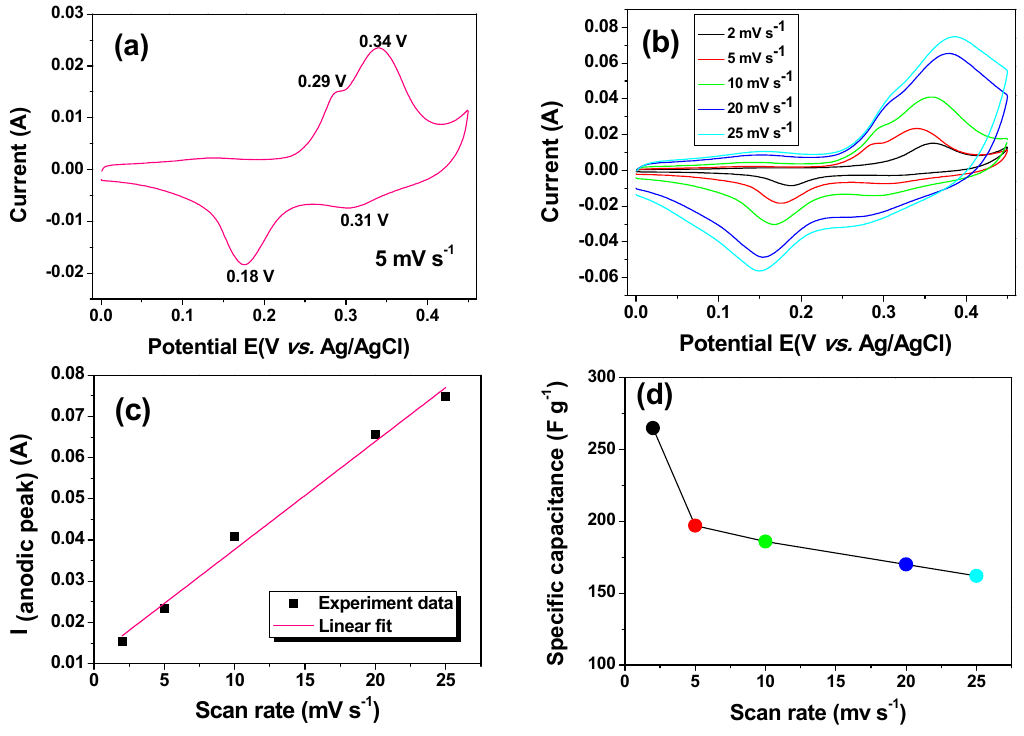
Figure 4. Capacitive performance of the as-prepared Co 3 O 4 nanorods in a potential range of 0–0.45 V. ( a ) Cyclic voltammetric (CV) curve at a scan rate of 5 mV s − 1 ; ( b ) CV curves at different scan rates; ( c ) peak current as a function of scan rate from ( b ); ( d ) rate dependent specific